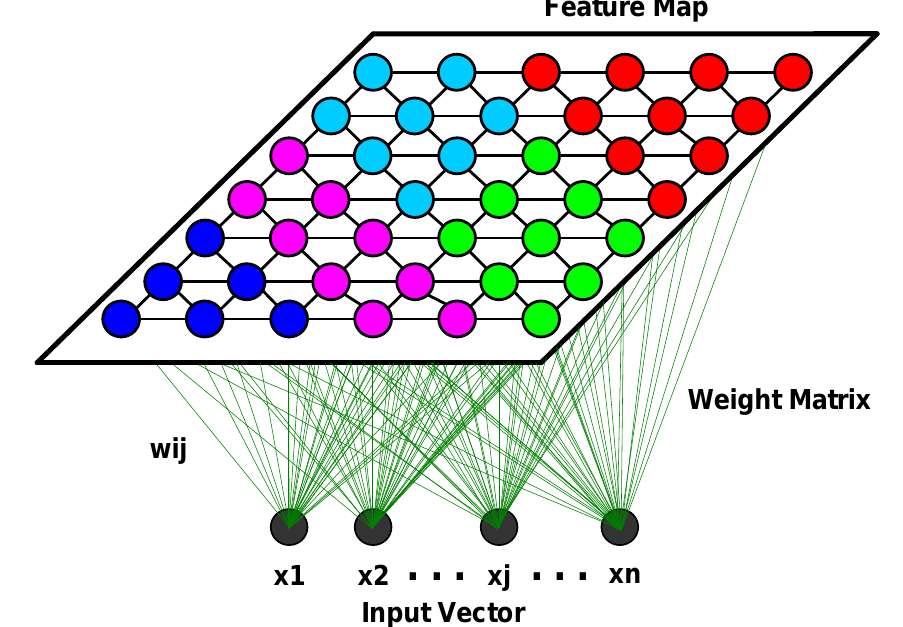
Figure 11. Self-organizing map (SOM) architecture.